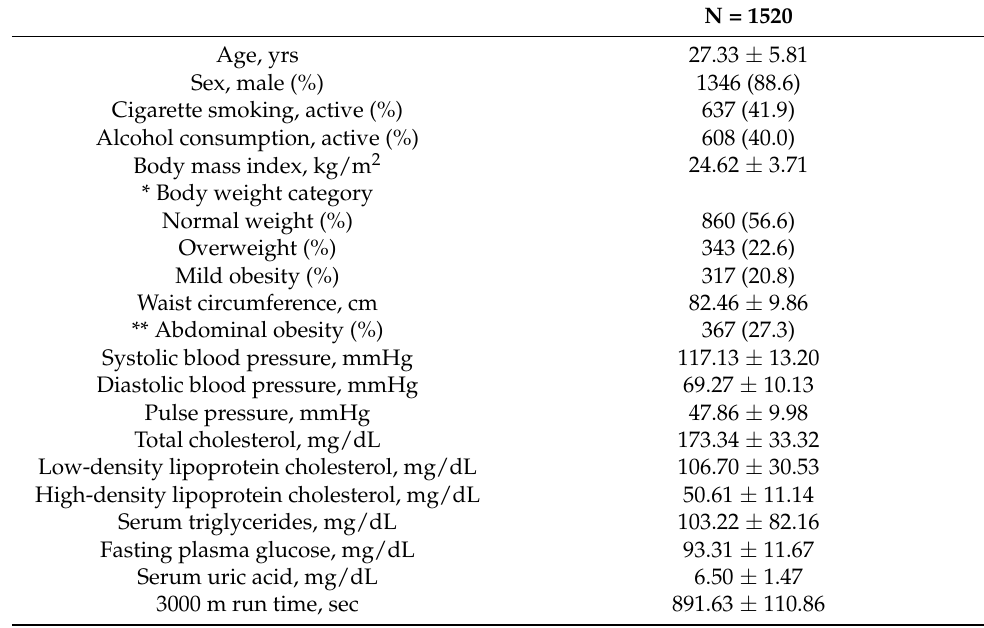
Table 1. Clinical characteristics of the military